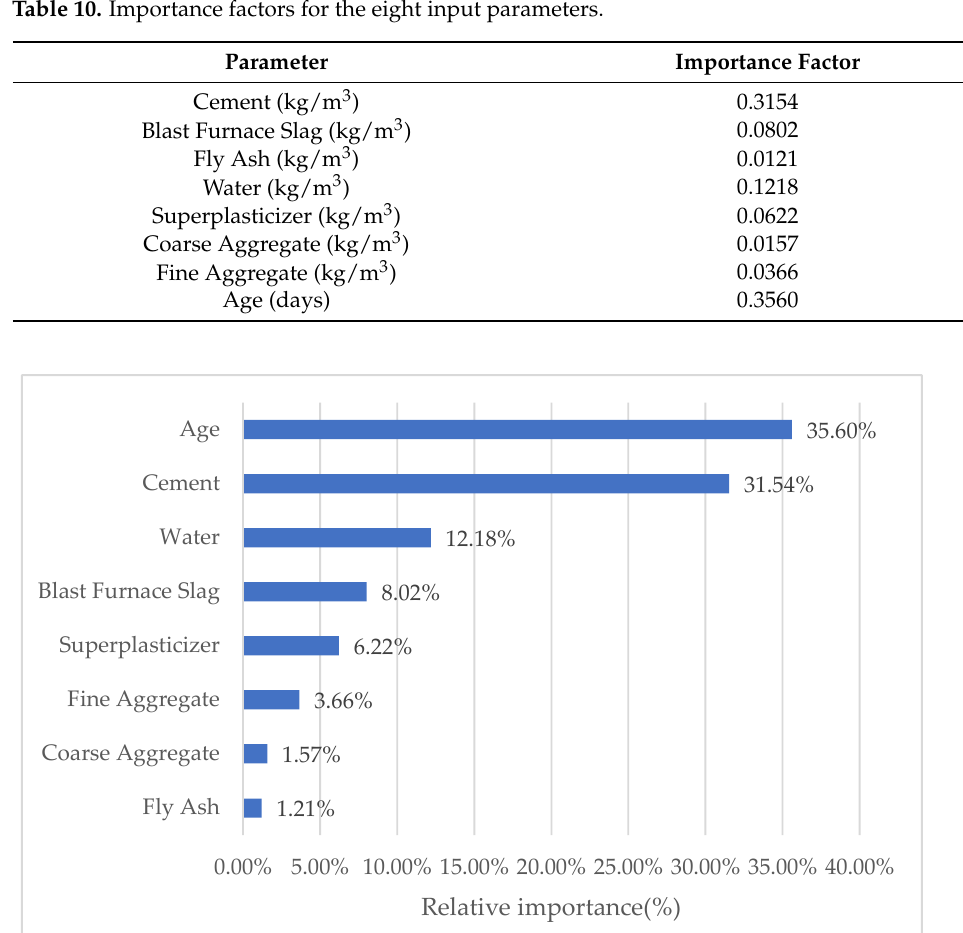
Figure 16. R2 and RMSE value of five folds. Figure 16. R 2 and RMSE value of five folds. Table 10. Importance factors for the eight input parameters. Table 10. Importance factors for the eight input parameters.